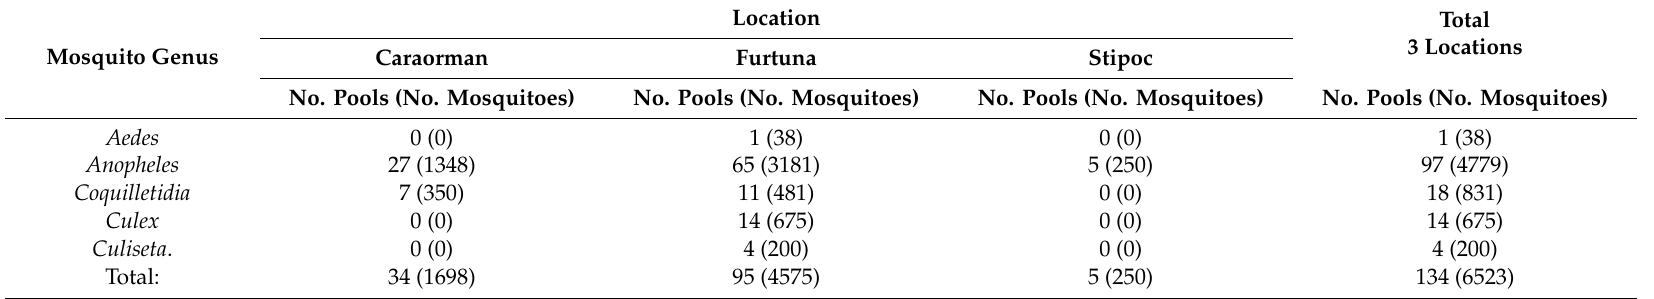
Table 2. Mosquito genus composition, number of pools, and individual mosquitoes from three di ff erent locations within the